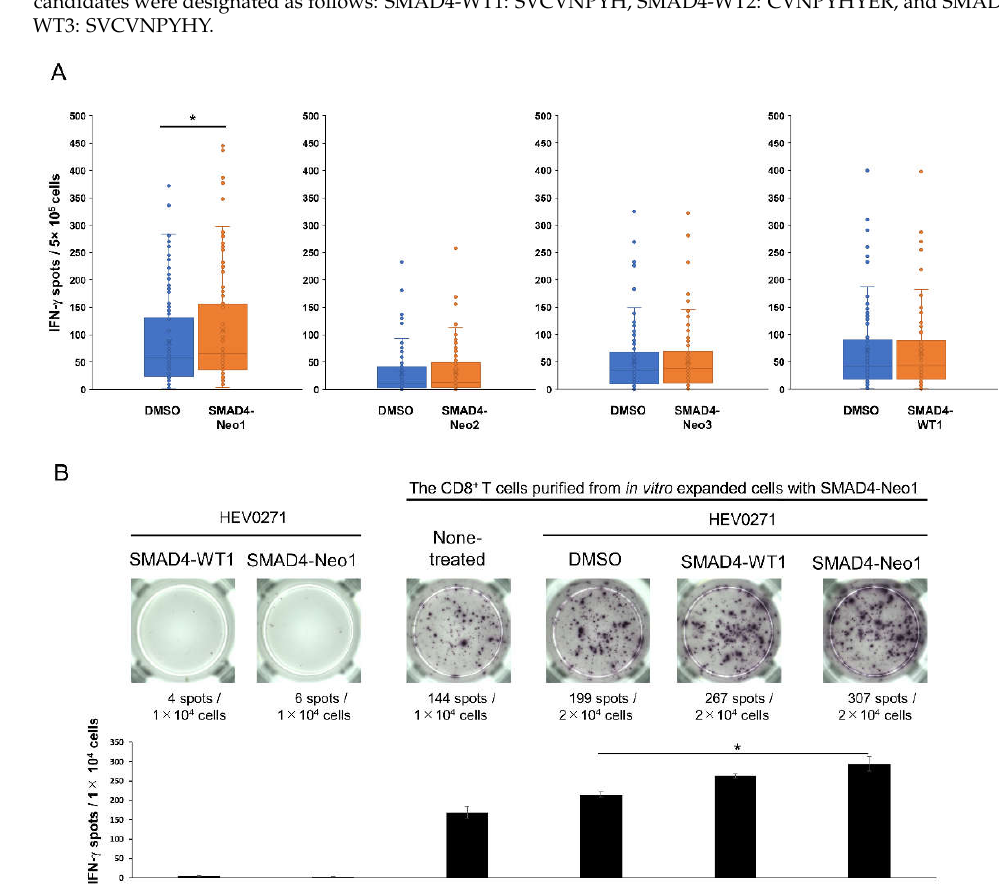
Figure 3. Detection of CD8 + T cell response to HLA-A*11:01 restricted SMAD4 P130L neoantigen in MPE. ( A ) WT1 tetramer-CD8 + T cells sorted from MPE 1st were expanded with HPL-IFN-DCs con- taining each predicted neoantigen peptide for SMAD4 P130L . For ELISpot assay to detect IFN-γ pro- duction after in vitro expansion, these cells were stimulated using each SMAD4 P130L peptide. Reac- A Wilcoxon signed-rank test was performed, * p < 0.05. ( B ) CD8 + T cells purified from in vitro